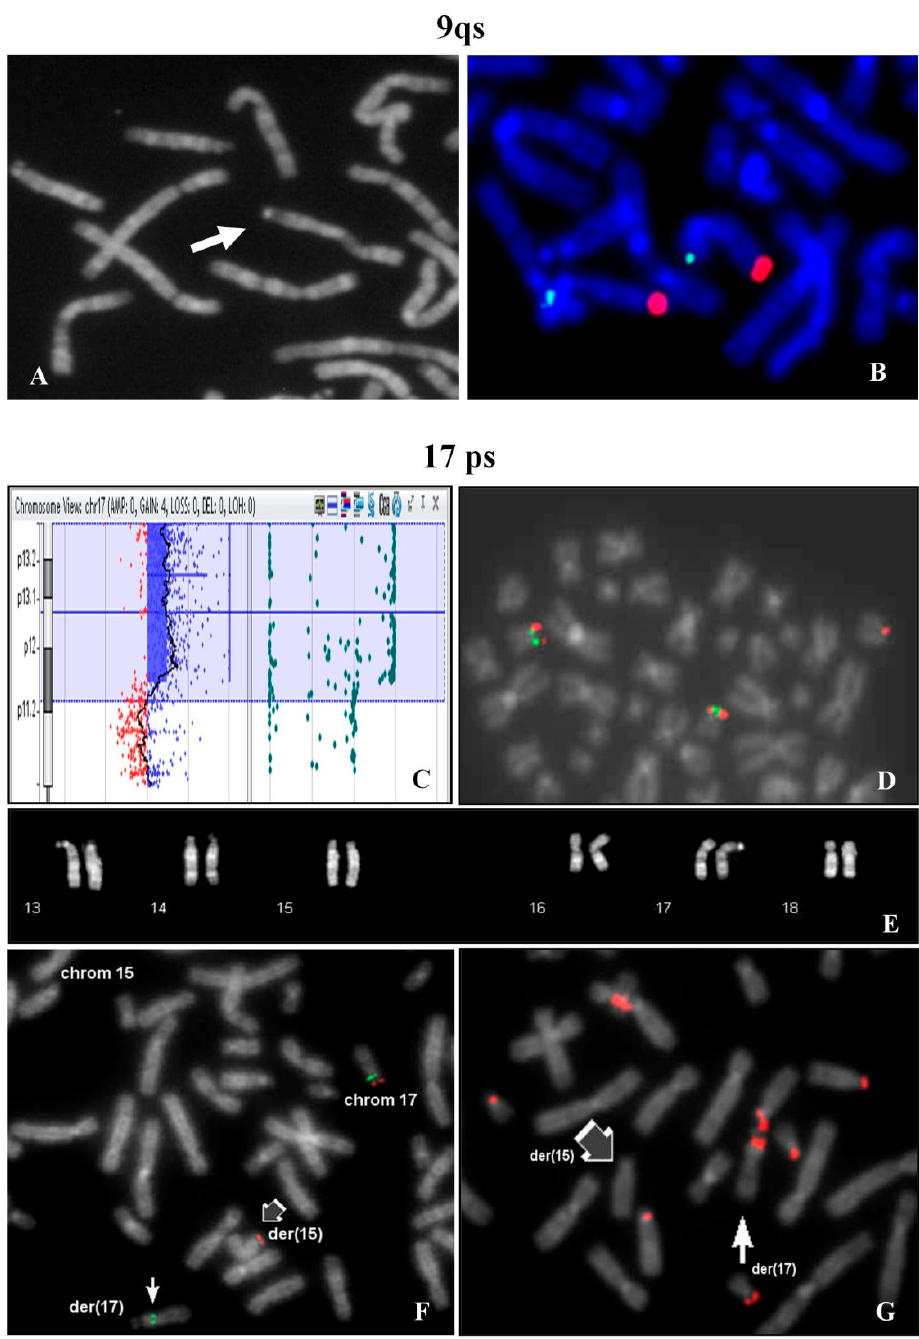
Figure 3. 9qs: ( A ) partial metaphase showing the 9qs of the father (arrow); ( B ) specific subtelomeric probes of chromosome 9 (green p-arm, red q-arm). 17ps: ( C ) array CGH showing the segmental trisomy of 17p; ( D ) FISH on partial metaphase of the fetus (direct analysis) with LIS1 specific probe (17p13.3, red signals) and FLI specific probe (17p11.2, green signals). The trisomic 17p region was translocated on chromosome 15p (red signal). ( E ) QFQ banding of 13, 14, 15, 16, 17 and 18 maternal chromosomes; ( F ) FISH on partial metaphase of the mother with LIS1 probe (17p13.3, red signals) and FLI probe (17p11.2, green signals). A balanced translocation between 17p and 15p was identified (single green and red signals). ( G ) FISH on partial metaphase of the mother with β -satellite probe: the white arrow indicates the positive p-arm of derivative 17 (in association with one chromosome D ) and the gray arrow the negative derivative chromosome 15. All images were captured at 100 × magnification (see materials and methods for details).